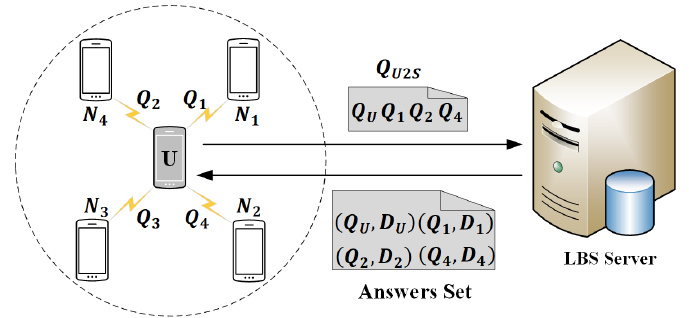
Figure 3. Query to the LBS